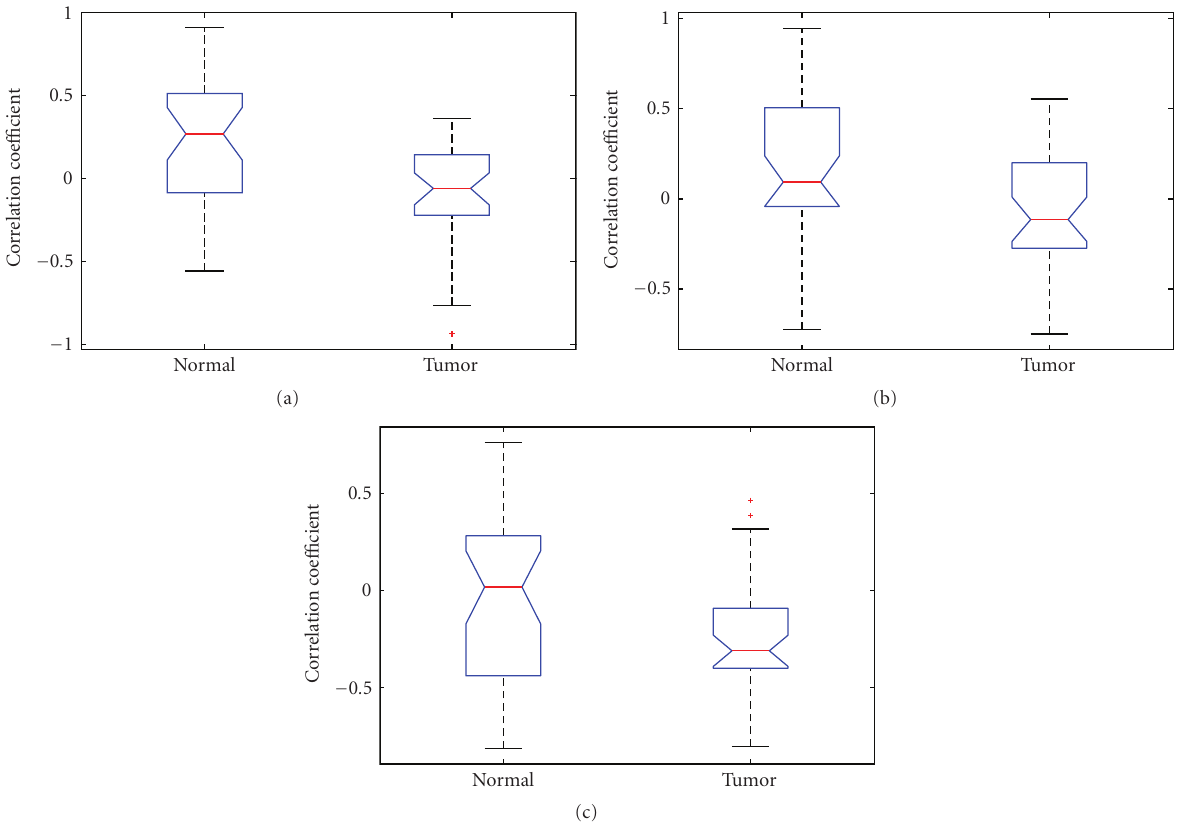
Figure 2: (a) Boxplot for MAGI2 (ARIP1)–Smad3. Pr( θ < 0 . 05) = 0 . 986. (b) Boxplot for EWSR1–Smad4. Pr( θ < 0 . 05) = 0 . 954. (c) Boxplot for TRAP1–TgfbetaR2. Pr( θ < 0 . 05) = 0 .